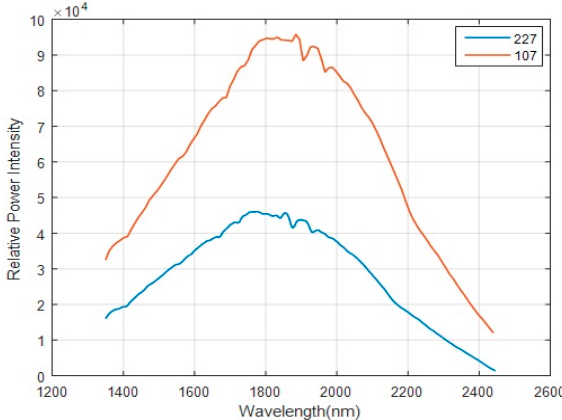
Figure 12. Relative power intensity of the light source. The curves are obtained by the column scan mode with the orders of 107 and 227.